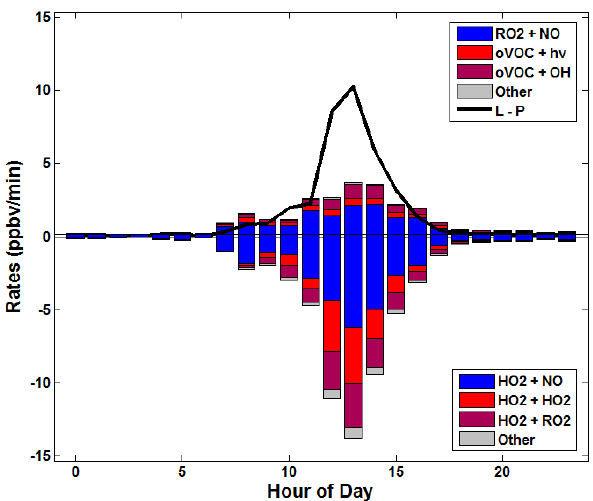
Fig. 8. UWCM model calculated HO 2 loss and production rates in different photochemical pathways (indicated as the colored